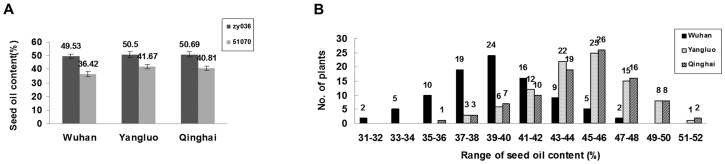
Phenotypic variation in seed oil content in the parents and DH population.
A. Distribution of average seed oil content ± SE in the parents zy036 and 51070. Values in figure are average seed oil content (%) in the high-oil parent zy036 and low-oil parent 51070 in Wuhan (2010), Yangluo (2011), and Qinghai (2011) trials. B. Frequency distribution of phenotypic variability in seed oil content (%) in the DH population. Numbers in figure show number of plants in the DH population in Wuhan (2010), Yangluo (2011), and Qinghai (2011). In these three environments, seed oil content showed approximately continuous variations and normal distribution patterns.